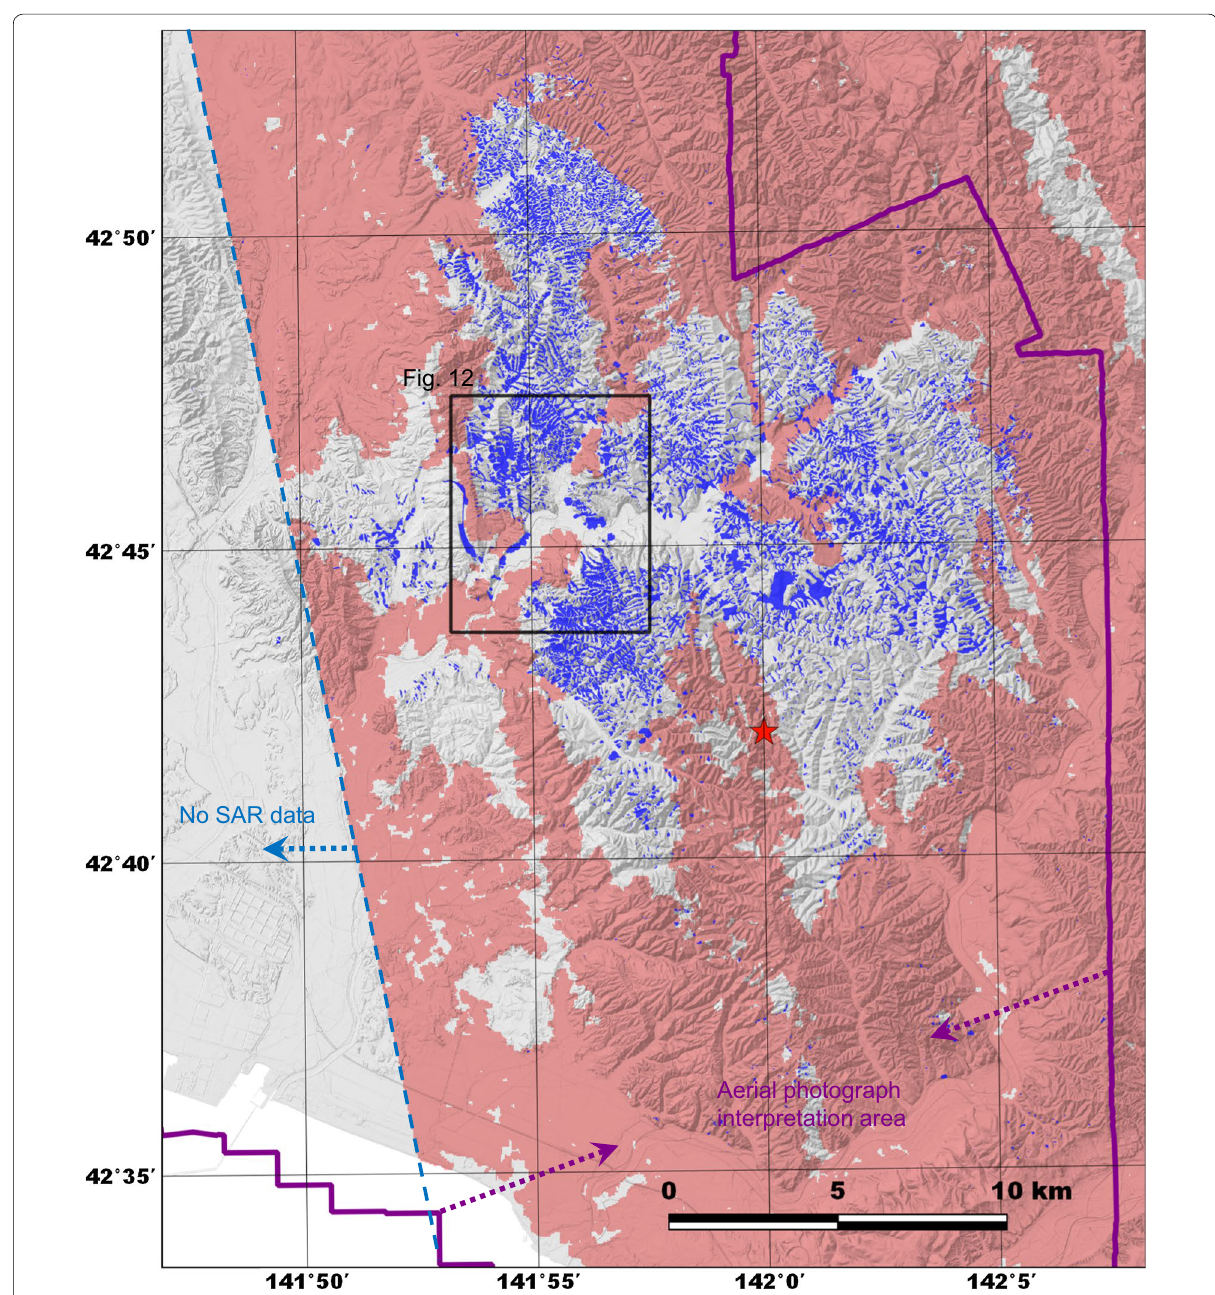
Fig. 11 Landslides identified from aerial photographs (dark blue; GSI 2018b) on shaded relief map. Pink indicates areas where the normalized phase noise deviation was small enough for the phase unwrapping in Figs. 5 and